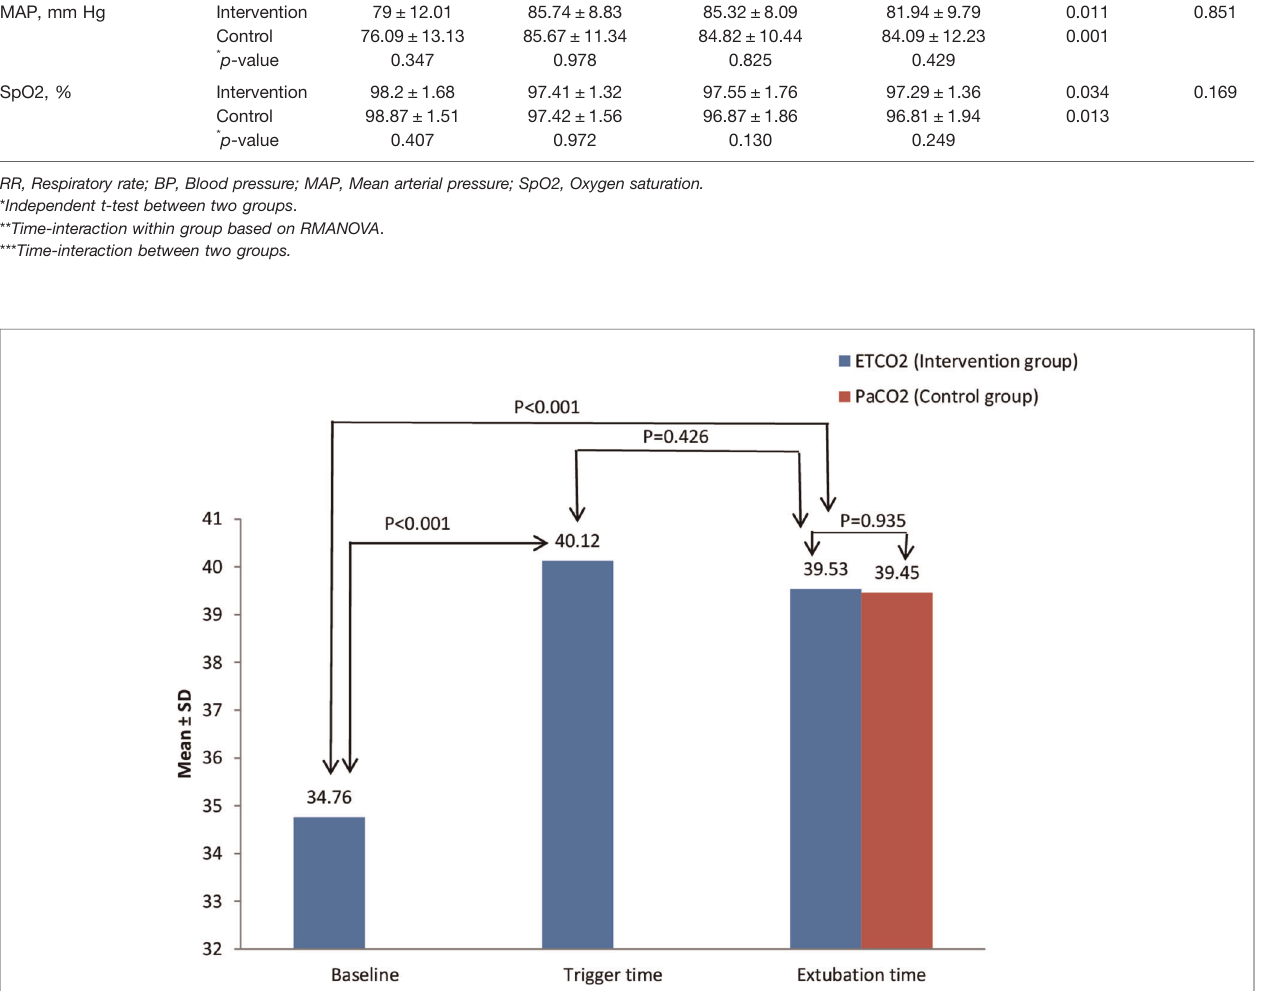
FIGURE 3 | ETCO2 level distribution in the intervention group compare with PaCO2 in the control group at extubation